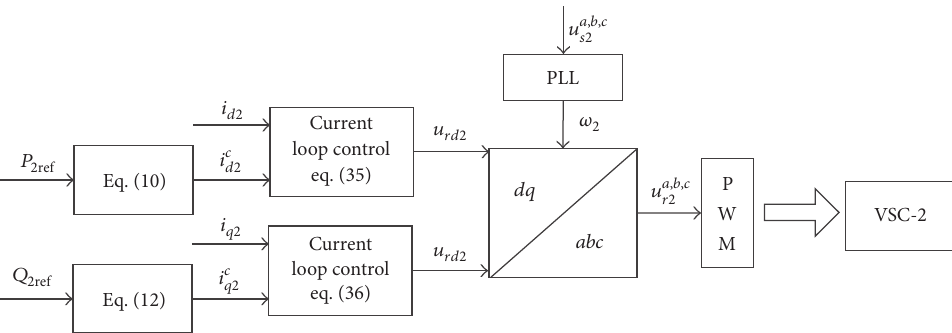
Figure 4: Block diagram of designed controller for VSC-2.